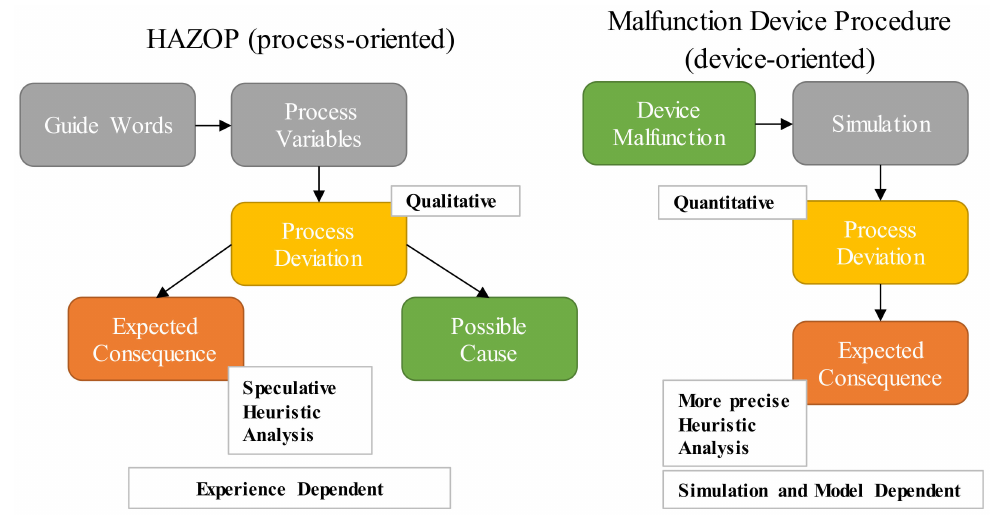
Figure 2. Characteristics of HAZOP and malfunction device procedures.